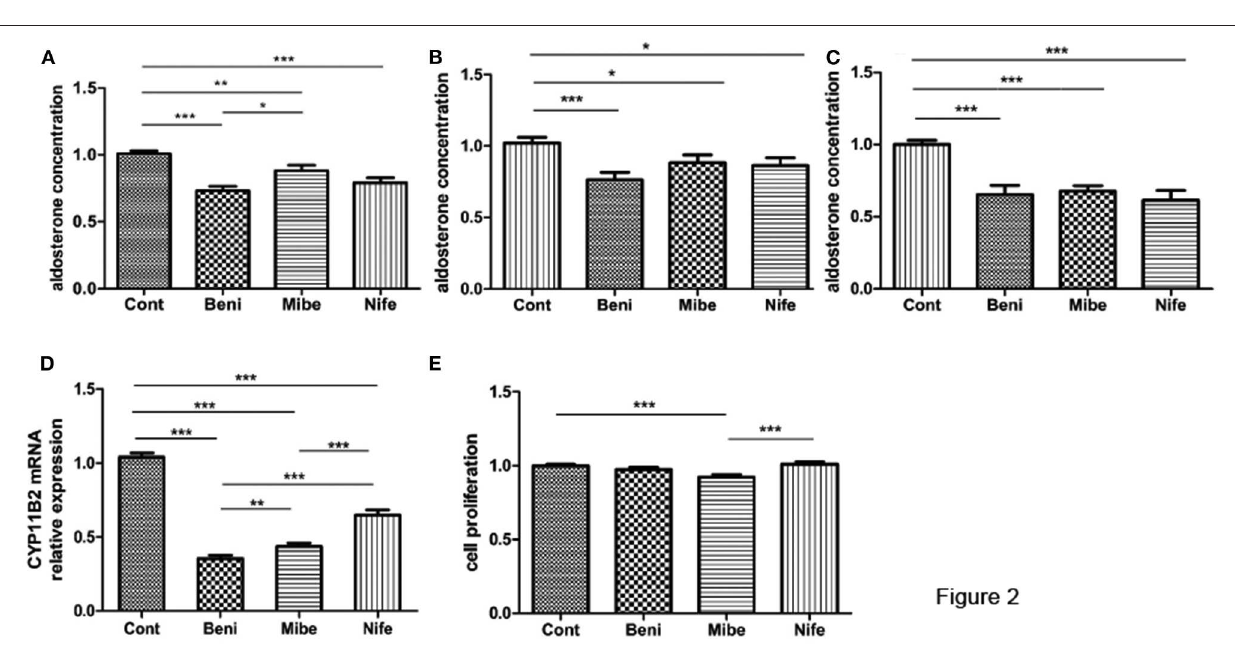
FIGURE 2 | Effects of CCBs with a final concentration of 10 µ M on aldosterone secretion and proliferation in APA cells. (A) Effects on aldosterone secretion (mean ± SE, N = 15); B and C. Effect on aldosterone secretion in different genotypes (mean ± SE) (B) KCNJ5 G151R , N = 7; (C) KCNJ5 L168R , N = 5; (D) Effects on CYP11B2 mRNA expression (mean ± SD, N = 9); (E) Effects on cell proliferation (mean ± SD, N = 3). Cont, control; Beni, benidipine; Mibe, mibefradil; Nife, nifedipine; Aldosterone concentration or cell proliferation in control group was set as 100%; * P < 0.05; ** P < 0.01; *** P <